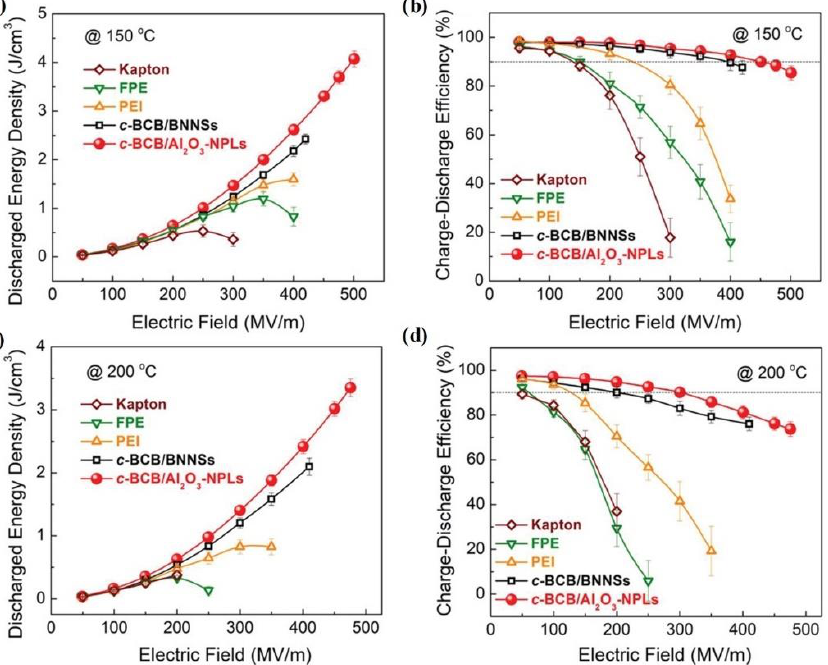
Figure 13. Discharged energy density and charge – discharge efficiency of high-temperature dielectric polymers and the c - BCB nanocomposites measured at 150 °C ( a , b ) and 200 °C ( c , d ). Reproduced with permission from Ref. [84]. Copyright 2019, Wiley –